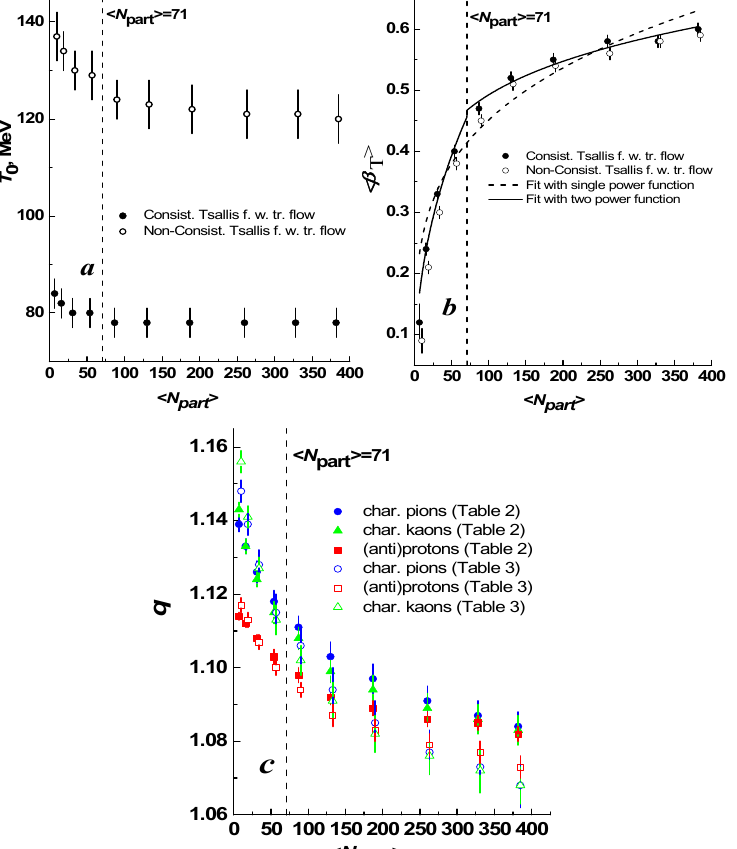
(cid:10) (cid:11) N part Figure 3. The dependencies of the T 0 ( a ) and (cid:104) β T (cid:105) ( b ) parameters ( • ) in Pb + Pb collisions √ Figure 3. The 〈𝑁 (cid:3043)(cid:3028)(cid:3045)(cid:3047) 〉 dependencies of the T 0 ( a ) and 〈𝛽 (cid:3021) 〉 ( b ) parameters ( ● ) in Pb + Pb collisions at (cid:10) (cid:11) s nn = 2.76 TeV extracted using Equation (5) and given in Table 2; ( c )—the N part at dependence (cid:3493)𝑠 (cid:3041)(cid:3041) = 2.76 TeV extracted using Equation (5) and given in Table 2; ( c )—the 〈𝑁 (cid:3043)(cid:3028)(cid:3045)(cid:3047) 〉 dependence for for the extracted q values given in Table 2 for the charged pions ( • ), kaons ( (cid:78) ), and protons and the extracted q values given in Table 2 for the charged pions ( ● ), kaons ( ▲ ), and protons and anti- antiprotons ( (cid:4) ). The results (Table 3) obtained for the respective particles in Pb + Pb collisions at protons ( ▪ ). The results (Table 3) obtained for the respective particles in Pb + Pb collisions at (cid:3493)𝑠 (cid:3041)(cid:3041) √ = 2.76 TeV using Equation (4) are shown by the corresponding open symbols. The dashed and solid s nn = 2.76 TeV using Equation (4) are shown by the corresponding open symbols. The dashed curves in panel ( b ) are minimum 𝜒2 fits by the simple single-power (Equation (6)) and two-power and solid curves in panel ( b ) are minimum χ 2 fits by the simple single-power (Equation (6)) and (Equation (7)) functions, respectively, of the 〈𝛽 (cid:3021) 〉 versus 〈𝑁 (cid:3043)(cid:3028)(cid:3045)(cid:3047) 〉 dependence, respectively, ex- (cid:10) (cid:11) N part two-power (Equation (7)) functions, respectively, of the (cid:104) β T (cid:105) versus dependence, respectively, tracted using Equation (5). The data (open symbols), obtained using Equation (4), are slightly shifted extracted using Equation (5). The data (open symbols), obtained using Equation (4), are slightly along the positive direction of 〈𝑁 (cid:3043)(cid:3028)(cid:3045)(cid:3047) 〉 axis for better visibility. (cid:10) (cid:11) N part shifted along the positive direction of axis for better As seen from Figure 3a, the shapes of T 0 versus 〈𝑁 (cid:3043)(cid:3028)(cid:3045)(cid:3047) 〉 dependencies are similar in case of fits by both thermodynamically consistent as well as non-consistent Tsallis func- tion with transverse flow. At the same time, the absolute values of T 0 are consistently smaller in case of fits by the function in Equation (5), compared to those by the function